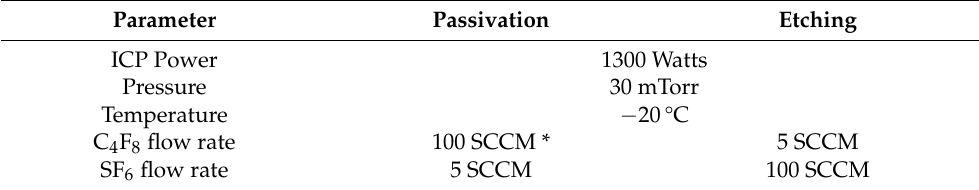
Table 1. DRIE parameters for etching patterns into silicon models. Parameter